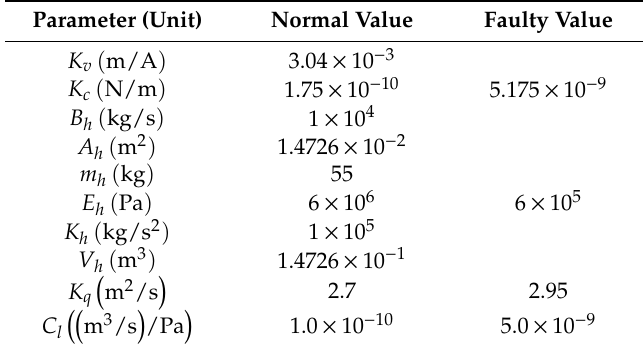
Table 1. Parameters of HA in normal and fault